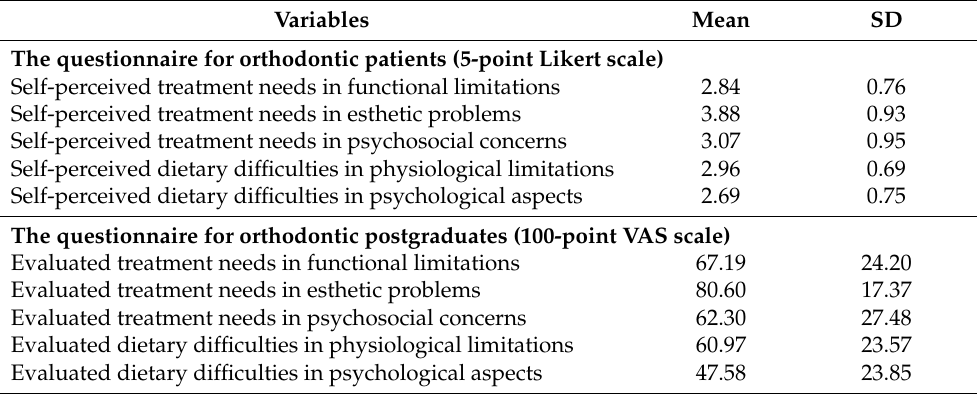
Table 4. OHRQoL perceived by patients and their orthodontists.